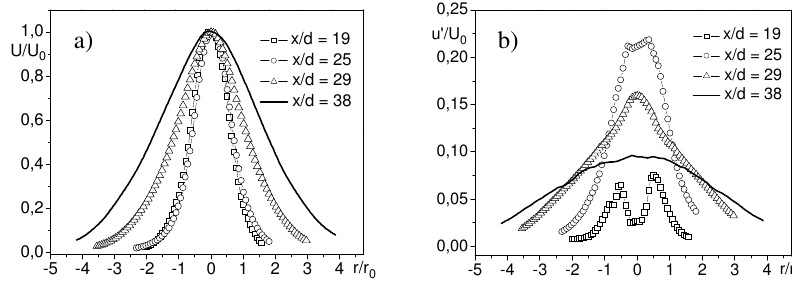
Fig. 2. The profiles of longitudinal mean velocities (a) and pulsation distributions (b) along the laminar-turbulent transition zone at the Reynolds number Re = 1700.